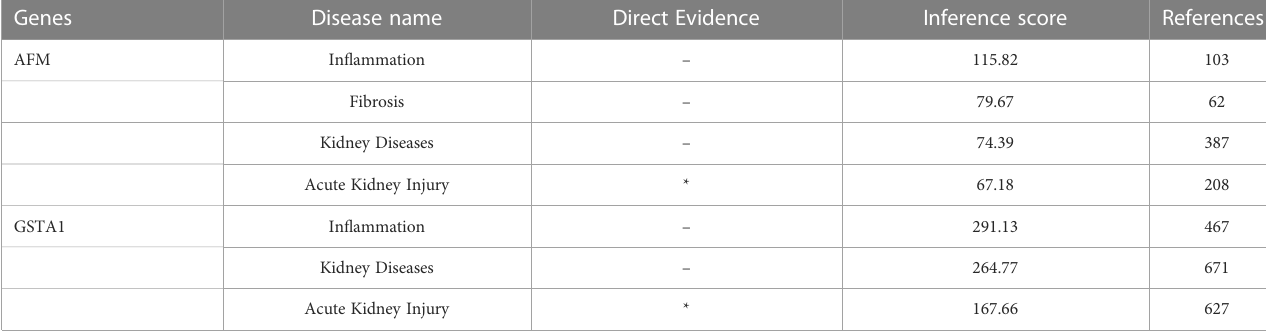
TABLE 2 Relationship to in fl ammation and kidney disease to key genes based on the CTD database.